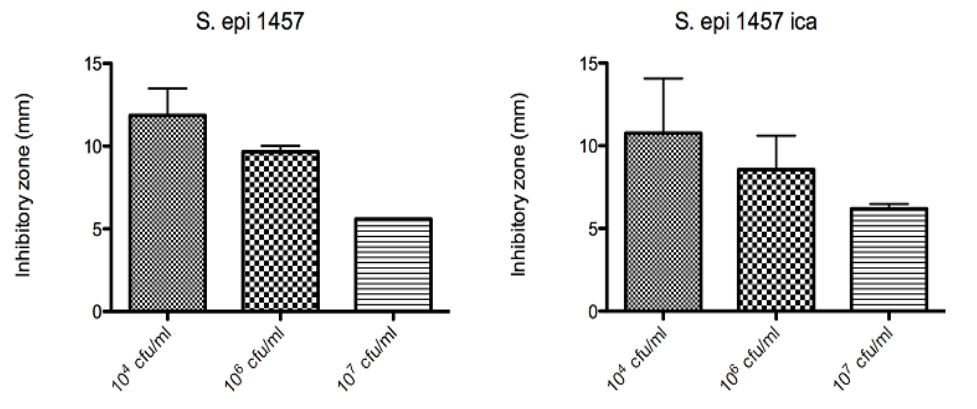
Figure 19. Inhibition zones for Au(111)-samples coated with compound 11 (10 -3 mol/L of 11 , coating duration of one day) at different starting concentrations of S. epidermidis 1457 (left) and S. epidermidis 1457 depleted of ica (biofilm forming gene)